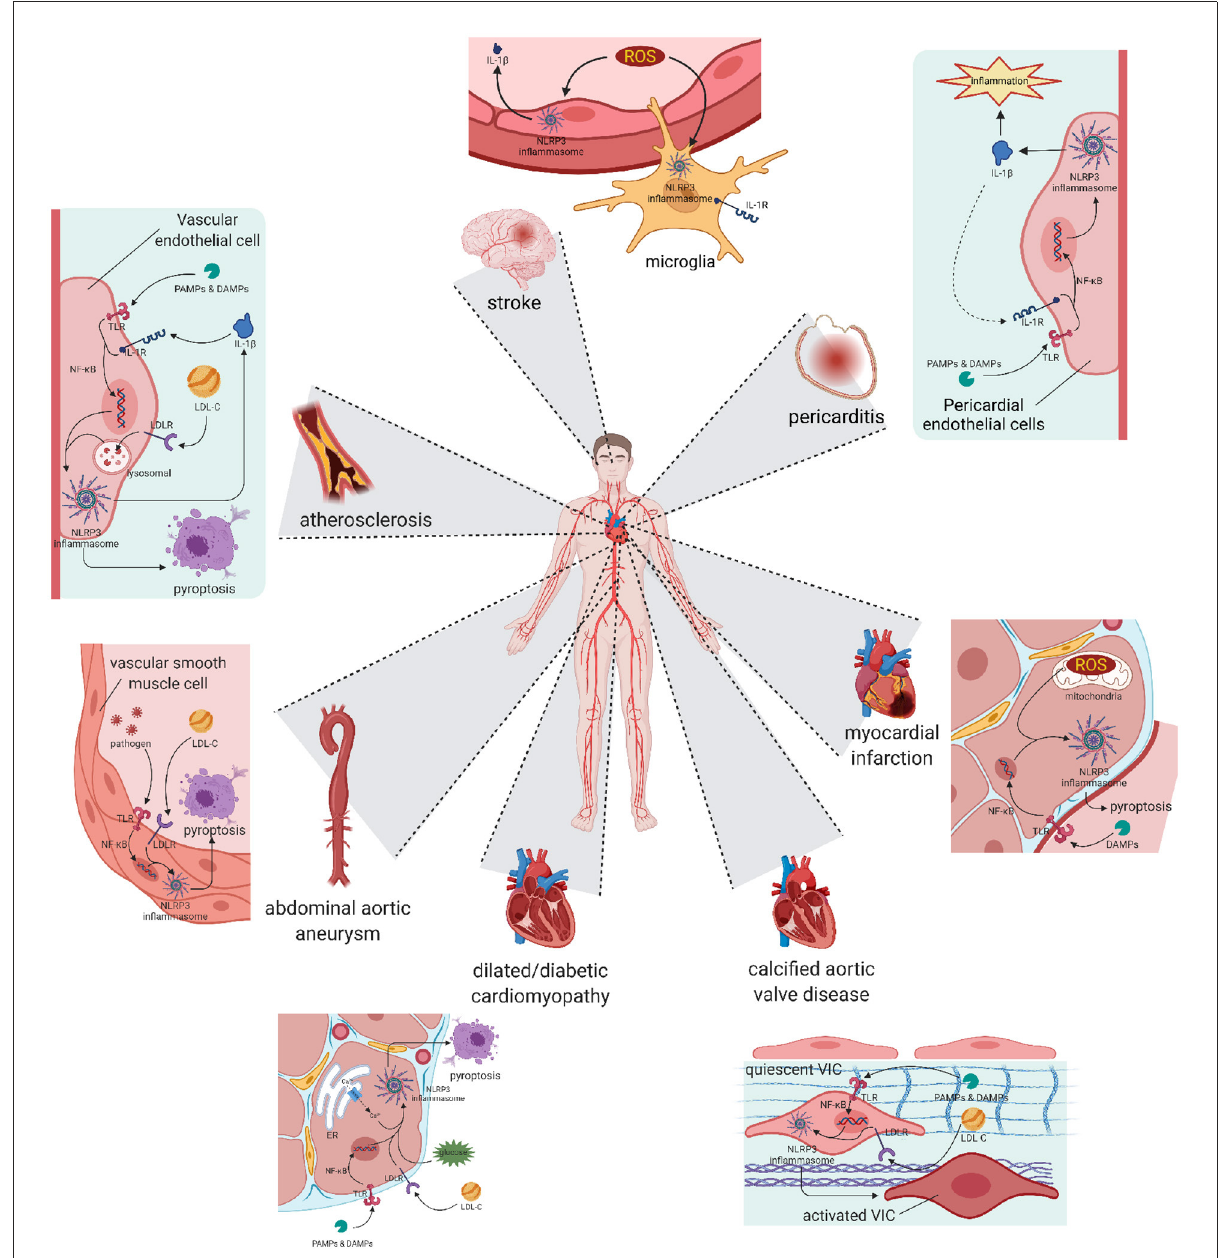
FIGURE2 Pyroptosis and differentiation mediated by NLRP3 inflammasome result in various cardiovascular diseases. Atherosclerosis: The activation of NLRP3 happened in vascular endothelial cells leads to cell pyroptosis and subsequent lipid accumulation, which induces the formation of atherosclerotic plaque. Pericarditis: The activation of NLRP3 happened in pericardial endothelial cells can be initiated by pro-inflammatory substances, and also worsens the inflammatory development of pericarditis. Abdominal aortic aneurysm: Activation happened in aorta smooth muscle cells leads to cell loss, resulting in abdominal aortic aneurysm. Myocardial infarction and Stroke: Activation happened in reperfusion cells exacerbates ischemia-reperfusion injury, worsens the myocardial infarction or stroke symptom. Cardiomyopathy: Chronic NLRP3 inflammation triggered by hyperglycaemia or hyperlipidemia promotes pyroptosis of cardiocytes and remodeling of ventricular, ending in dilated or diabetic cardiomyopathy. Calcific aortic valve disease: NLRP3 inflammation in aortic valve can activate quiescent valve interstitial cells into activated valve interstitial cells, initiating the calcific process of valve. NLRP3, nucleotide oligomerization domain (NOD)-, leucine-rich repeat (LRR)-, and pyrin domain (PYD)-containing protein